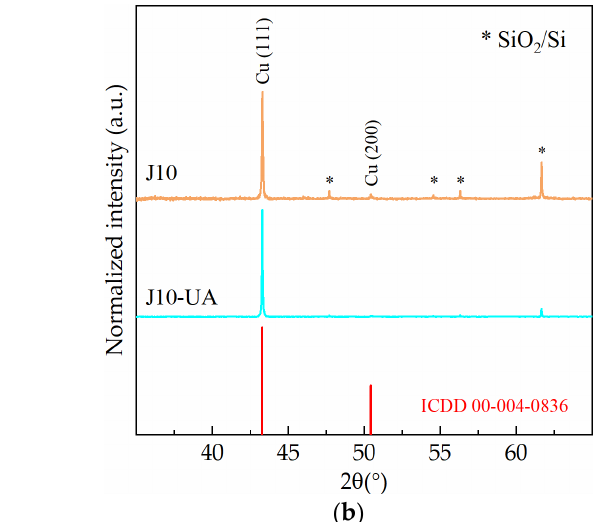
11 of 13 Figure 9. HAADF image of the Cu/Ru – W/SiO 2 /Si stack cross-section ( a ) and higher magnification of the same zone showing interfacial continuity between electroplated Cu film and Ru – W substrate ( b ). ( a ) ( b ) ( c ) Figure 10. Electrocrystallisation model for Cu on Ru – W thin films with and without ultrasonic agi- tation. Incomplete substrate coverage around large Cu particles without ultrasonic agitation ( a ), Cu particle detachment via mechanical stimulus ( b ), and filling of the coverage gaps after Cu particle removal ( c ). The use of UA does not appear to have an impact on the average particle size (Figure 11a), but it is interesting to note what it does to the electrocrystallisation of Cu on Ru – W in terms of preferential Cu growth along <111> directions. This preferential orientation, which is typically present in non-epitaxial growth [19], minimises interfacial energy and